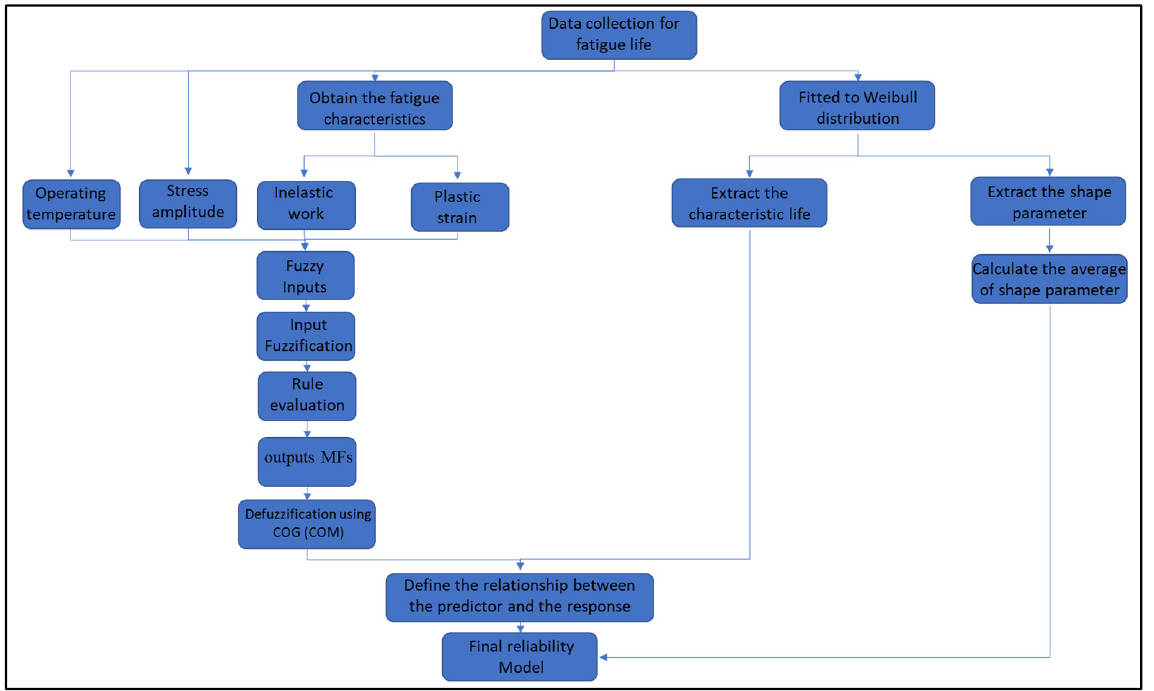
Figure 4. Prediction model flow chart.